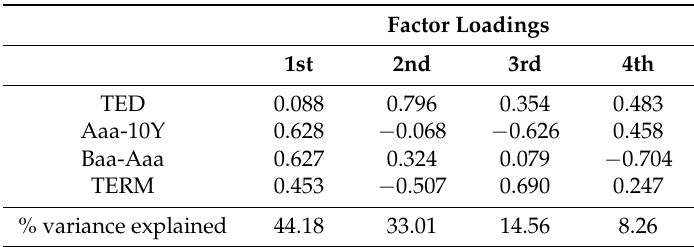
Table 2. Principal component analysis: financial market stress.